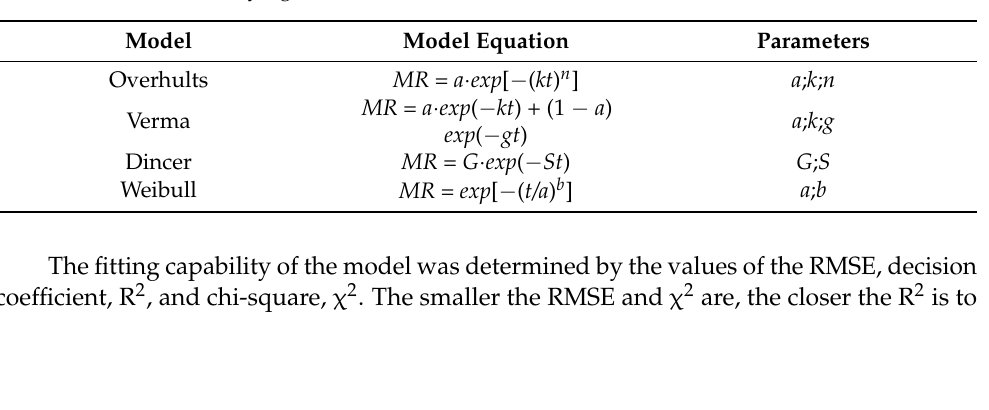
Table 1. Four common drying kinetic